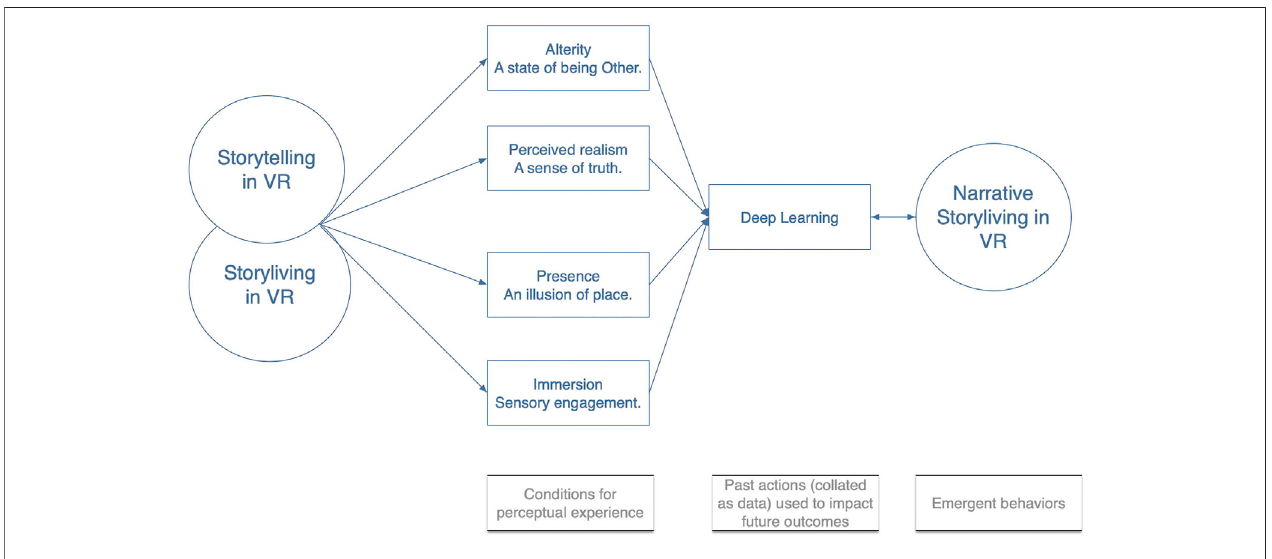
FIGURE 1 | Narrative storyliving in